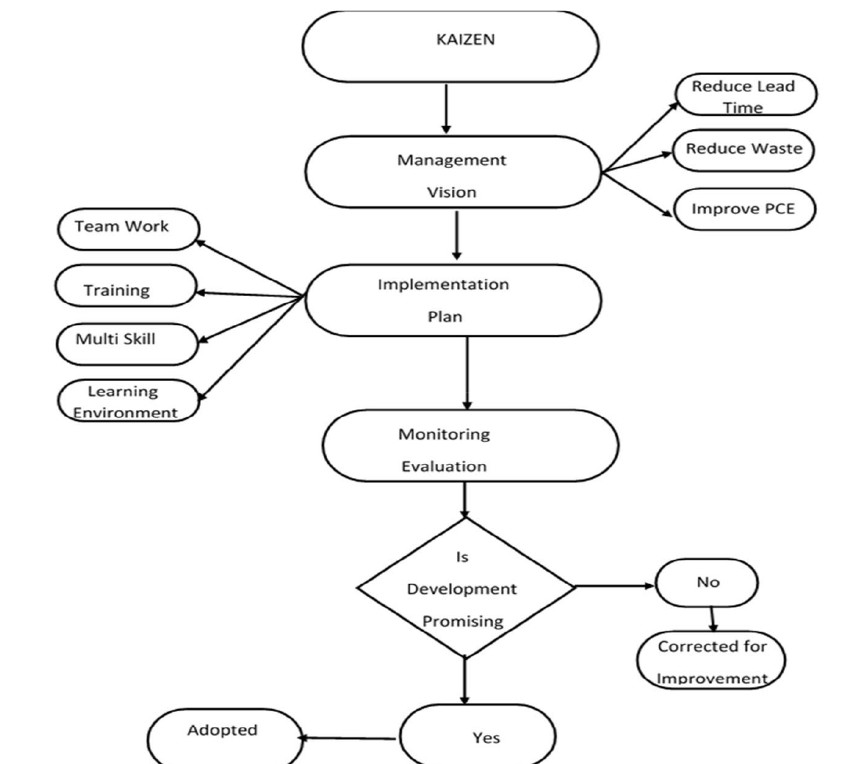
Figure 8. Strategic Framework for Kaizen